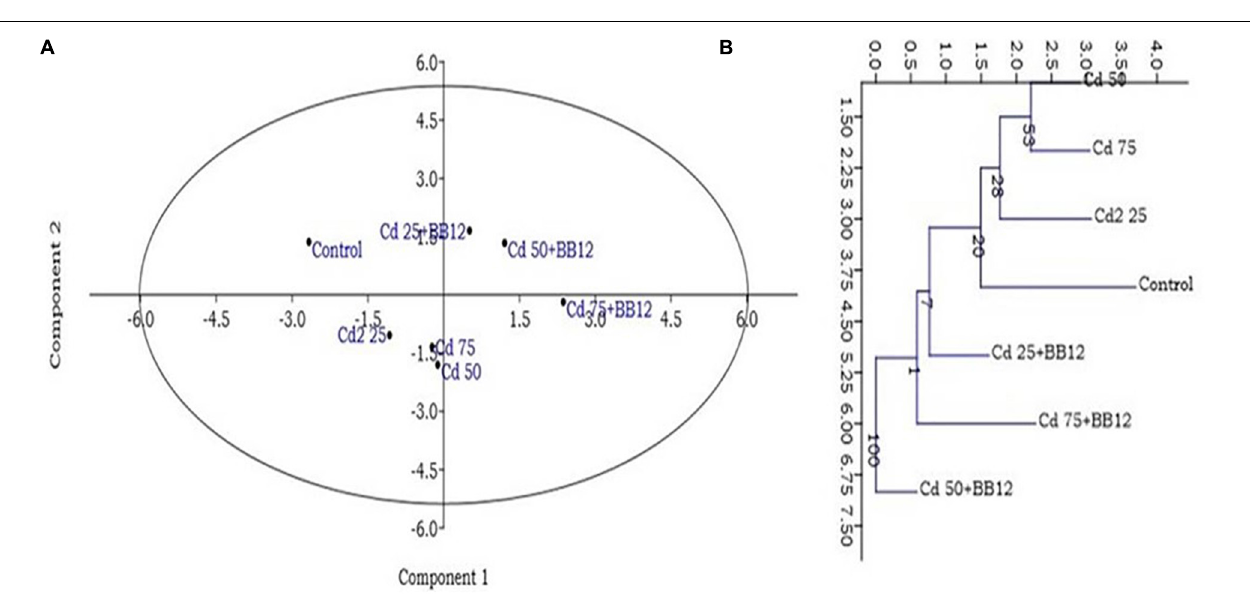
suggested that reduced growth parameters are proportional to